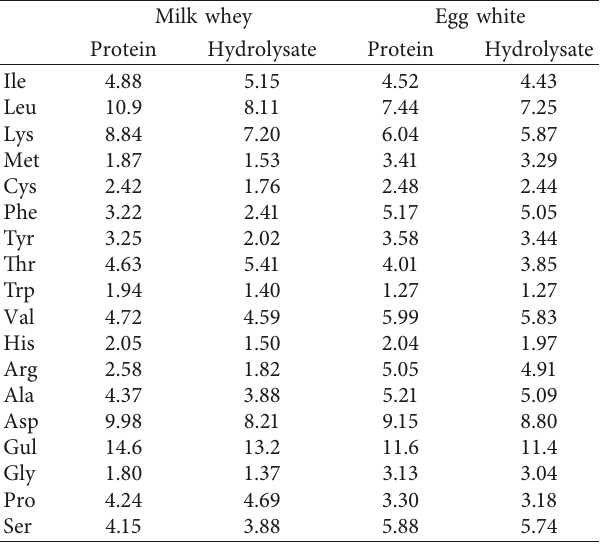
Table 1: Amino acid composition of protein or hydrolysate of milk whey or egg white (g/100g). Milk whey Egg white Protein Hydrolysate